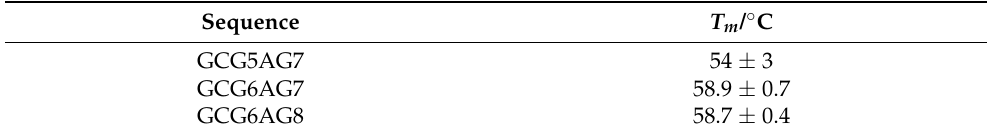
Table 1. Melting temperatures obtained in fits of the Boltzmann equation to the CD melting data of the studied DNA